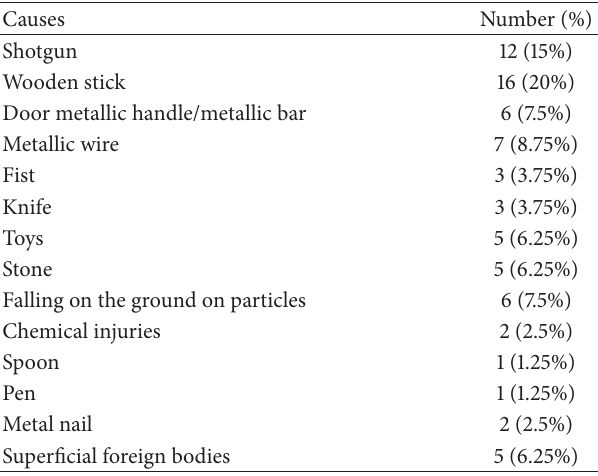
Table 2: Assault objects used in